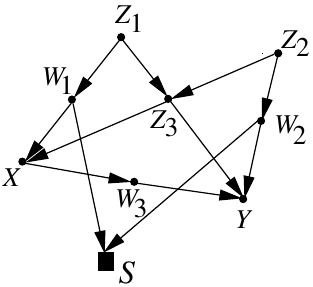
Figure 2: An augmented graph G tion into the